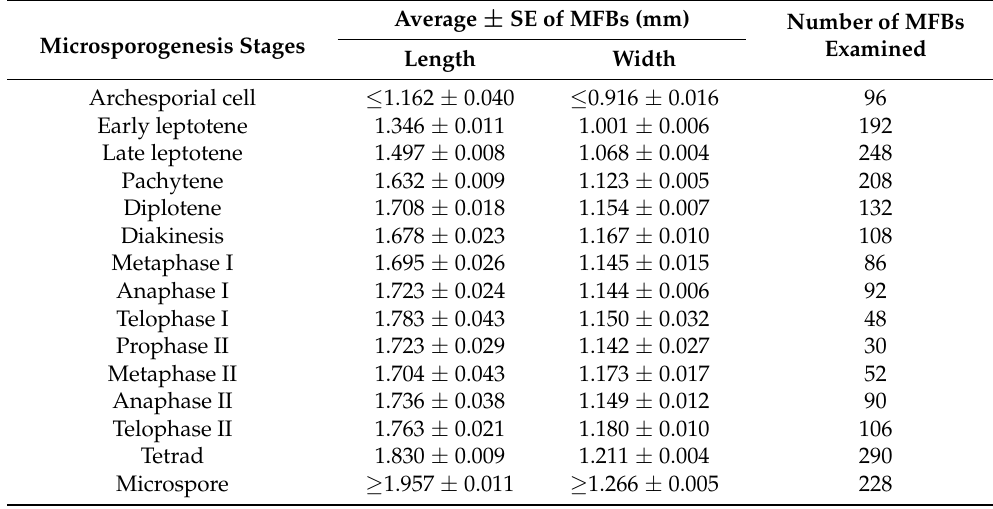
Table 1. Relationship between microsporogenesis and MFB size.